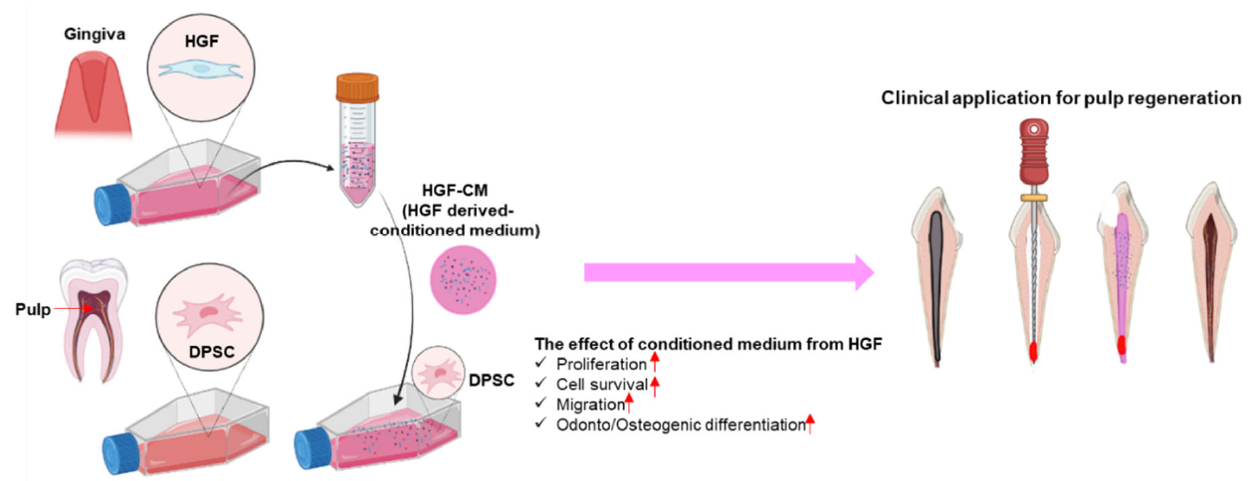
Figure 6. Schematic diagram of the effects of hGF-CM on DPSC culture and differentiation. hGF-CM increased cell proliferation and progenitor cell recruitment, recovered cell viability from oxidative stress, and enhanced osteo/odonto differentiation. Hence, hGF-CM can be a promising candidate for pulp regeneration therapy in the clinic .